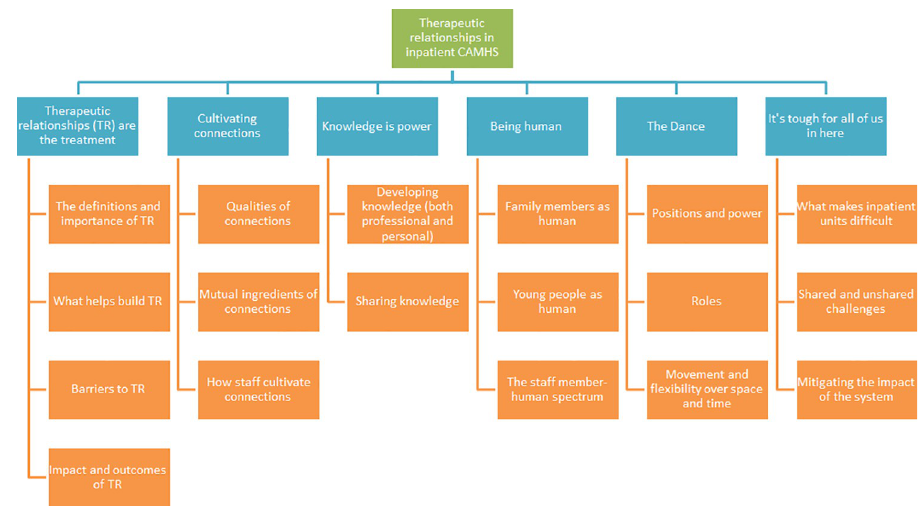
Fig 1. Theme and sub-theme structure.